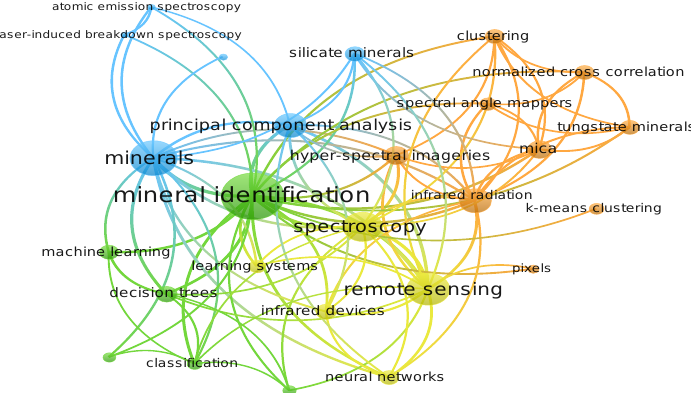
Figure 6. Keyword detection of machine-learning-based